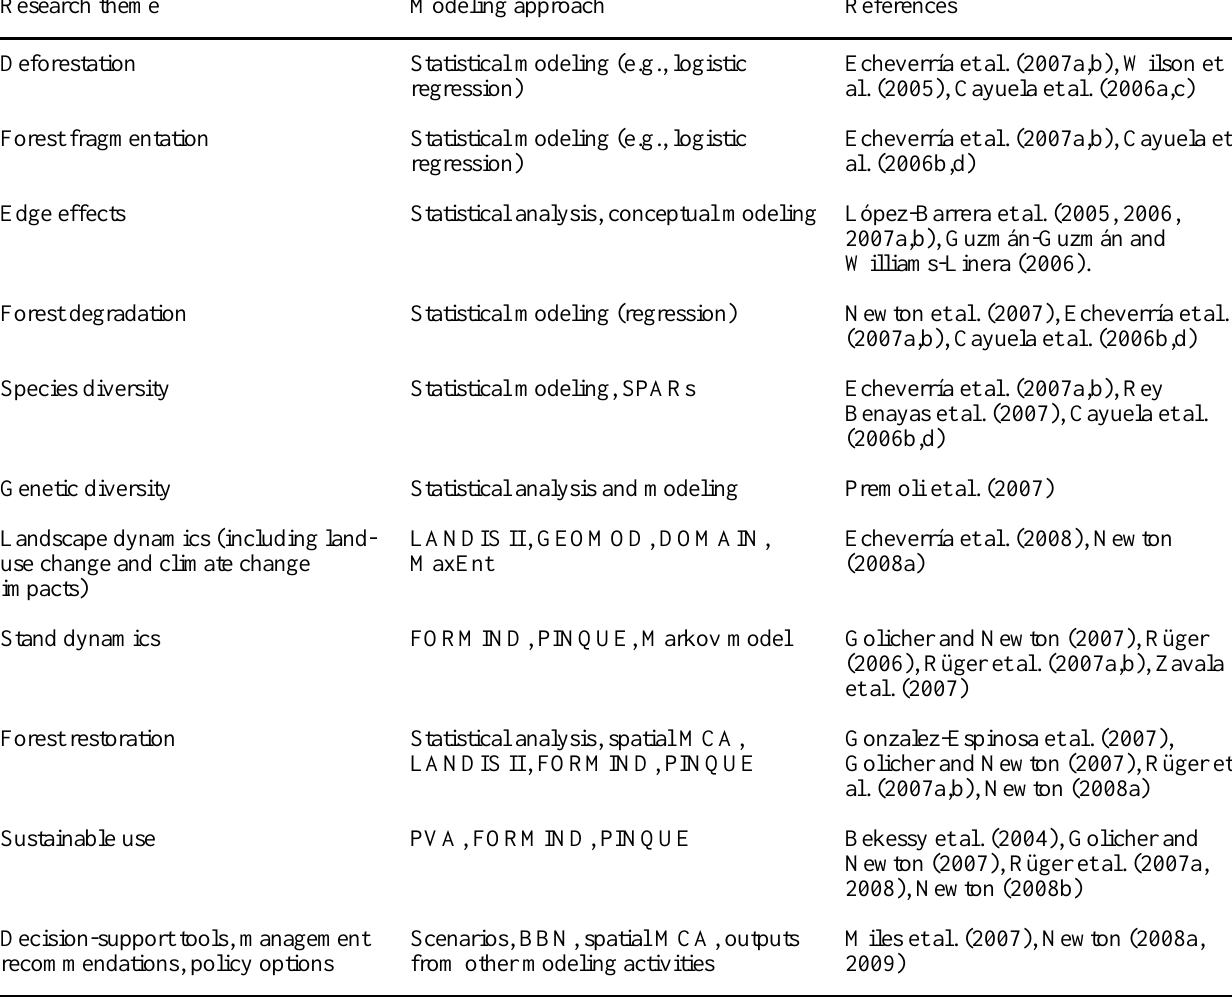
Table 1. Modeling approaches associated with research themes. (See Fig. 2 for relationships between research themes and Appendix X for details of modeling